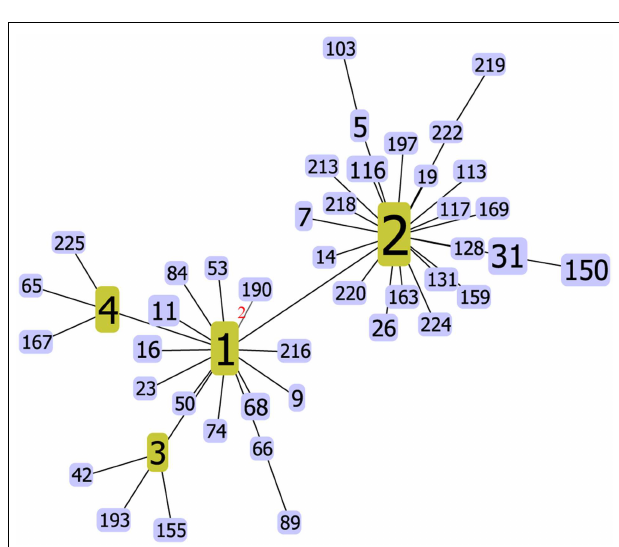
FIGURE 2 | V. parahaemolyticus “population snapshot” in China based on peptide sequence. The number of different alleles is indicated in the case of DLVs, all other pSTs are SLVs. In fact, only pST190 is a DLV of pST1, all other pSTs are SLVs of pST1, pST2, pST3, or